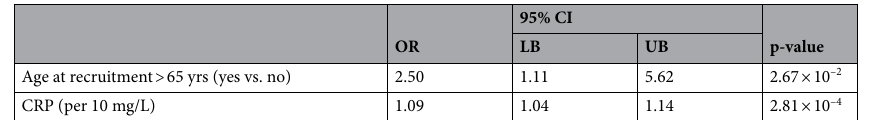
Table 2. Significant associations resulting from stepwise selection on multivariable logistic regression (n = 216, events = 37). CRP C-reactive protein. Outcome: SOFA > 2; covariates: age, sex, BMI, CRP, creatinine, CAD, diabetes, COPD, NPL, MBP, AKI, HYP and the reduction of anti-hypertensive therapy after hospitalization.